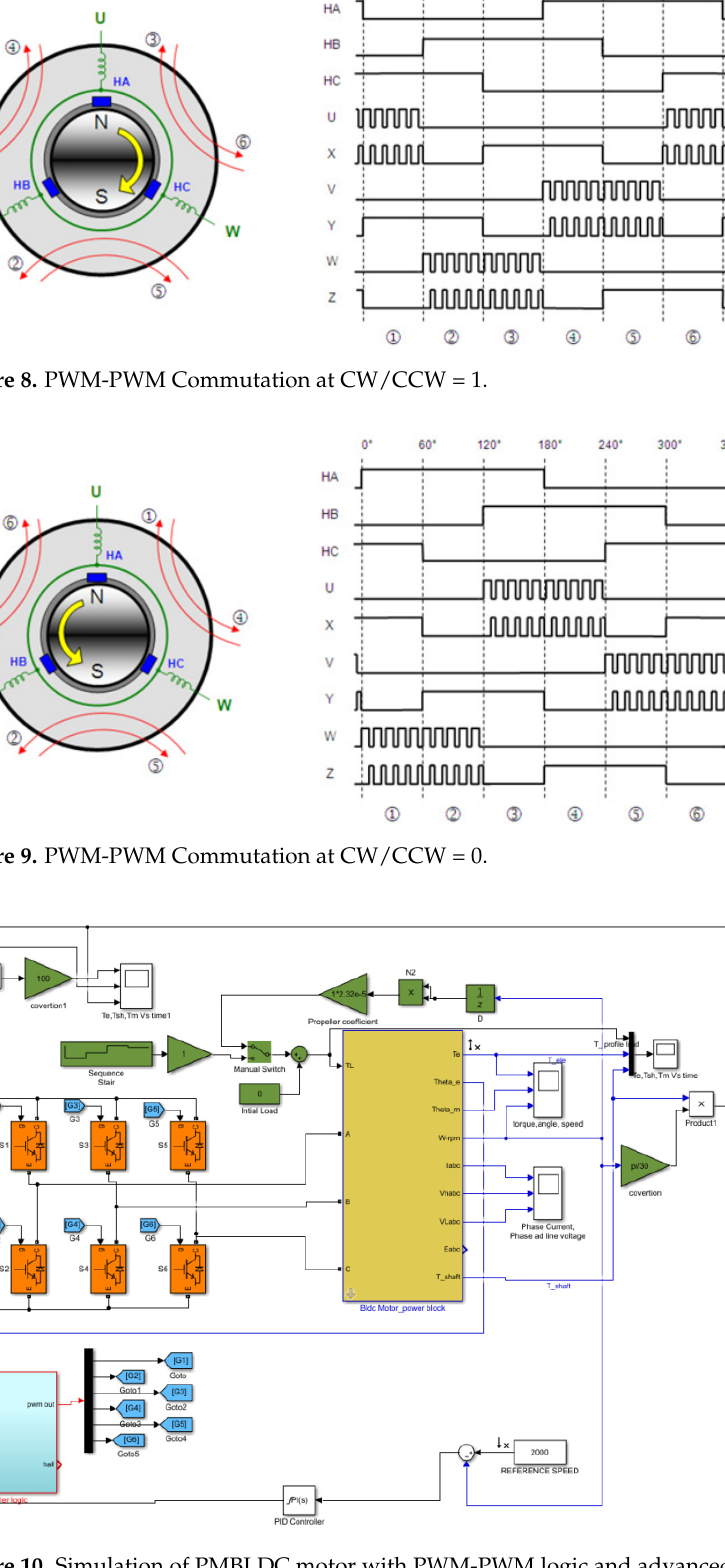
Table 1. Parameters of the PM BLDC Motor.